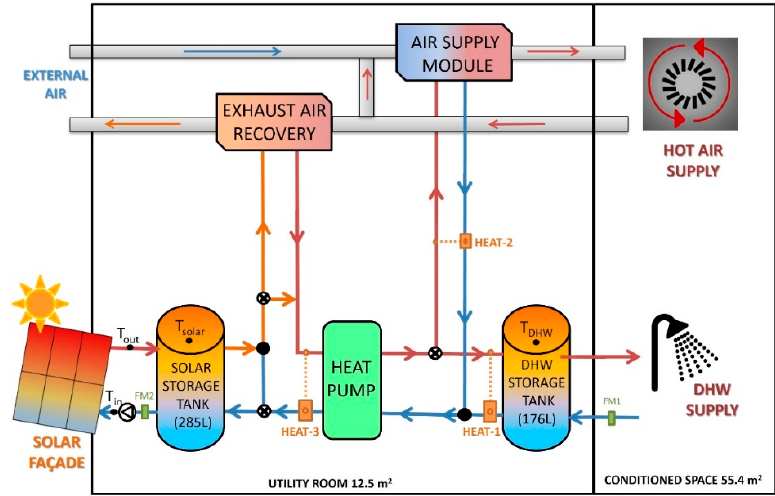
Figure 2. Scheme of the combined Active Solar Thermal Facade (ASTF) + heat pump system as installed at Kubik ® building.